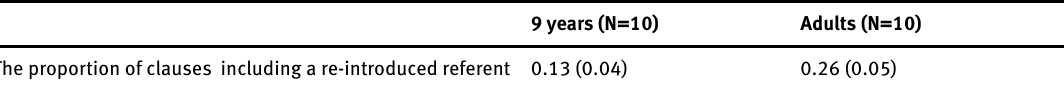
Table 6. The proportion of clauses in which a referent was reintroduced 9 years (N=10) Adults (N=10) The proportion of clauses including a re-introduced referent 0.13